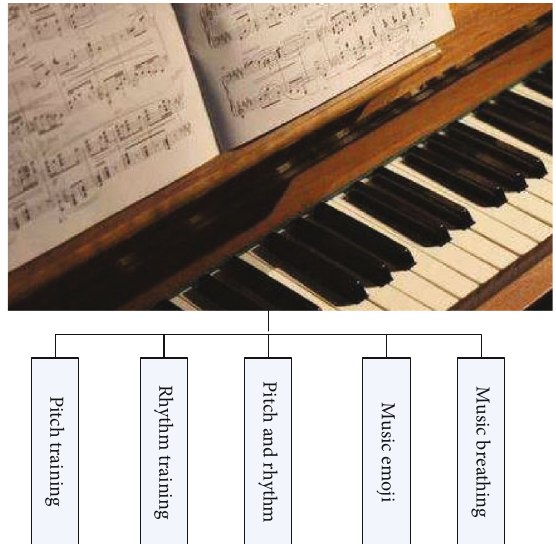
Figure 3: The structure diagram of reading music training